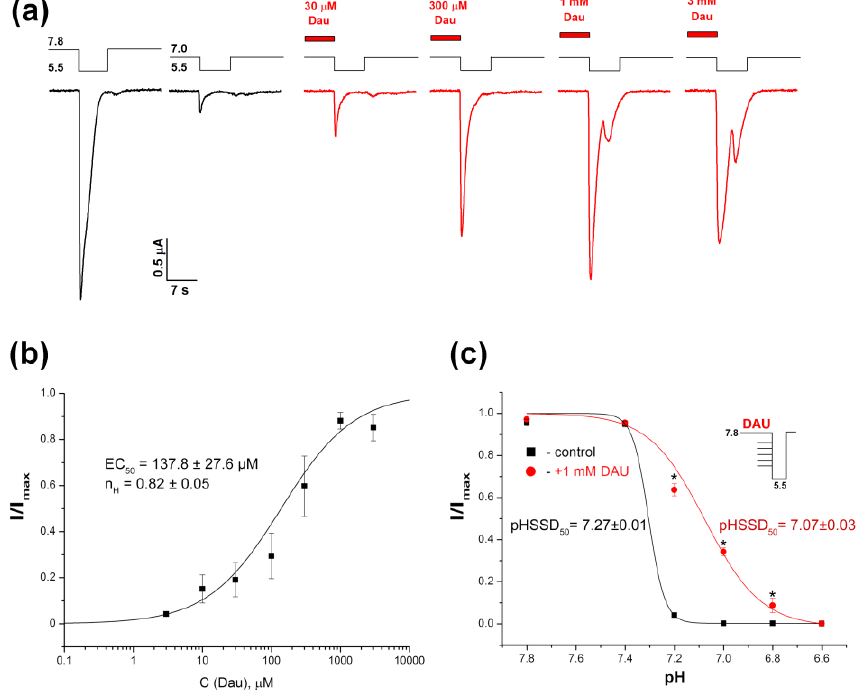
Figure 4. DAU-induced inhibition of steady-state desensitization (SSD) of rat ASIC1a. ( a ) Whole-cell currents obtained from the channels held at the conditioning pHs of 7.8 and 7.0 in response to a pH-5.5 stimulus, with (red) or without (black) a pre-incubation for 15 s with DAU at various concentrations. ( b ) The dose–response curve fitted to the logistic equation for peak ASIC1a amplitudes at various concentrations of pre-incubated DAU. I / I max is the main peak’s amplitude at a conditioning pH of 7.0, normalized to the maximum amplitude (I max ), which we calculated for each oocyte via individual fitting. Data are presented as mean ± SEM (n = 6). ( c ) pH dependence of the channel’s SSD without (black curve) and with (red curve) pre-incubation of 1 mM DAU. ASIC1a held at various conditioning pHs was activated by same pH 5.5 stimulus. The peak current amplitudes are plotted as a function of pH and fitted to the logistic equation. Data are presented as mean ± SEM (n = 5); * P < 0.05.